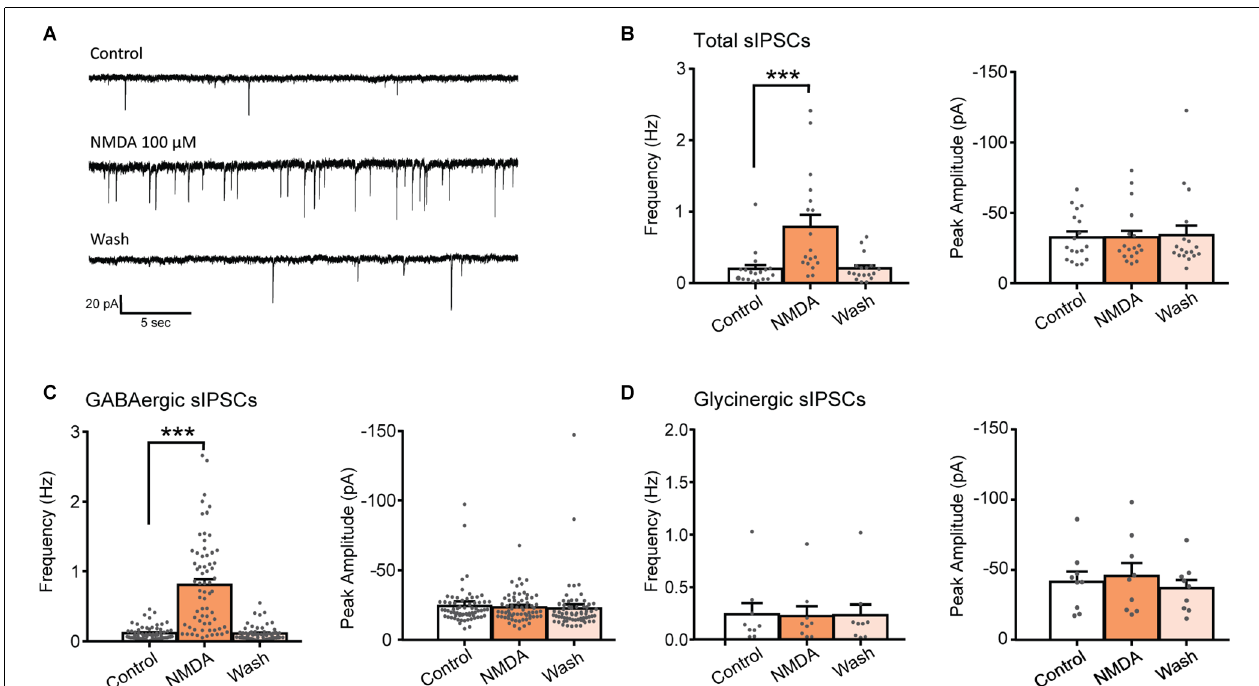
FIGURE 1 | NMDA increases GABA sIPSC frequency in lamina II neurons. (A) Representative traces of total sIPSCs recorded from lamina II neuron in spinal cord slice from C57Bl6 mouse before (Control) and during NMDA application (NMDA; 100 s after the beginning of application) and after a washout (wash; 360 s after the beginning of NMDA washout). (B) Bar graph showing total sIPSC frequency and peak amplitude before (Control) and during NMDA application (NMDA) and after a washout (wash; N = 18). NMDA application resulted in a reversible increase in sIPSC frequency without change in sIPSC amplitude. (C,D) Frequency and peak amplitude of GABAergic sIPSCs (C) and glycinergic sIPSCs (D) isolated pharmacologically. NMDA application enhances GABAergic sIPSC (recorded in presence of strychnine) frequency ( N = 67) but did not affect glycinergic sIPSCs, recorded in presence of bicuculline (D) ( N = 9). *** p < 0.001. Paired t-test was used. Error bars indicate